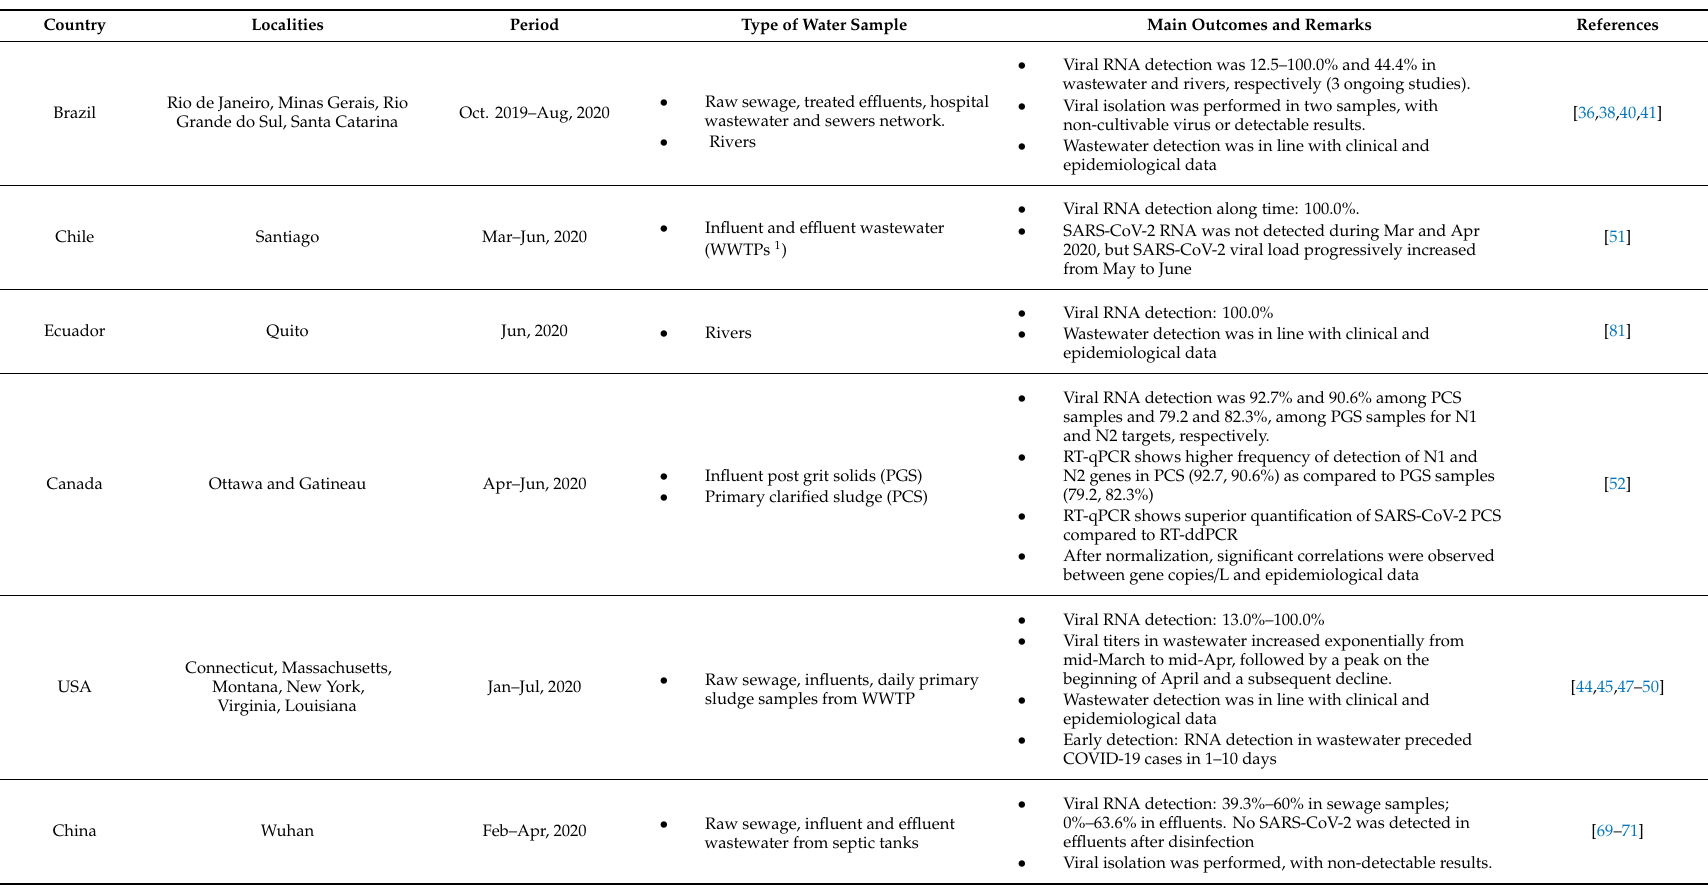
Table 1. Global studies on SARS-CoV-2 prevalence in wastewater and rivers, according to the country, January to August 2020. Country